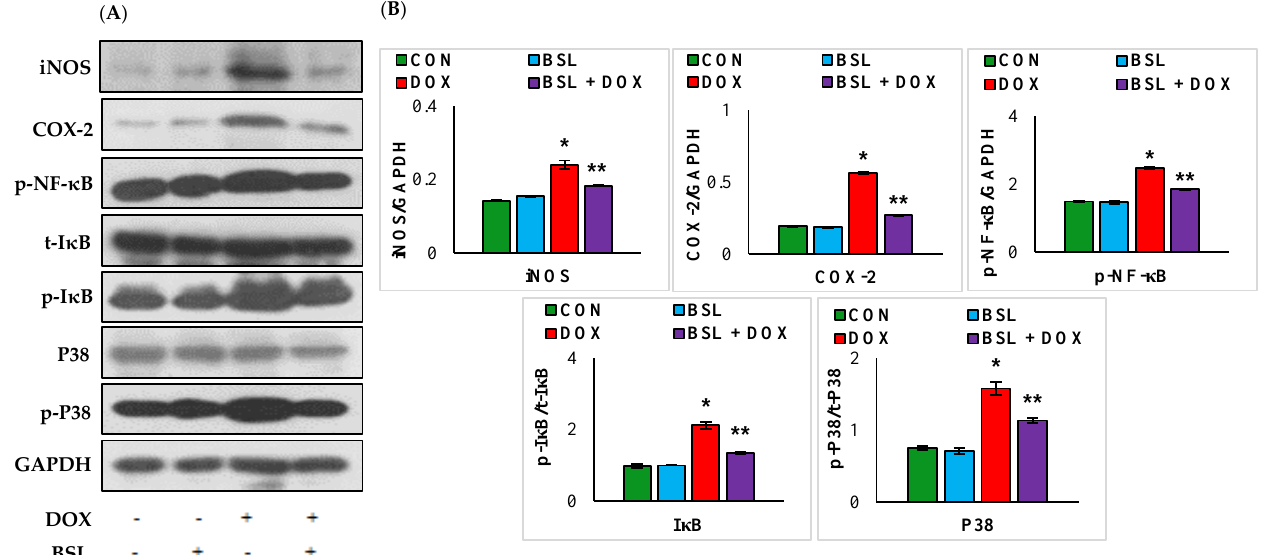
Figure 5. Effect of α -bisabolol on NF- κ B/MAPK signaling in the testis. ( A ) Representative images of Western blot analysis for COX-2, iNOS, p-NF- κ B-P65, p-I κ B α , I κ B α , p-p38, and p38. ( B ) Densitometric analysis of testicular protein expression levels of COX-2, iNOS, p-NF- κ B-P65, p-I κ B α , I κ B α , p-p38, and p38 assessed by immunoblotting analysis. Columns not sharing a common symbol (*, **) differ significantly from each other (* p < 0.05 vs. normal control, ** p < 0.05 vs. DOX control), CON-Control, BSL- α -Bisabolol, DOX-Doxorubicin, BSL + DOX- α -Bisabolol + Doxorubicin.